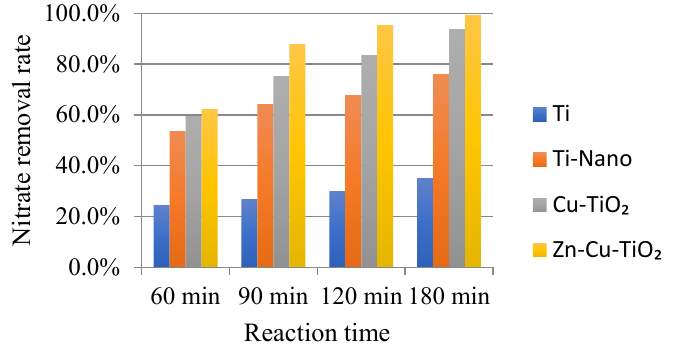
Figure 9. Comparison of the removal efficiencies of nitrate from deionized water and real groundwater for the different electrodes.